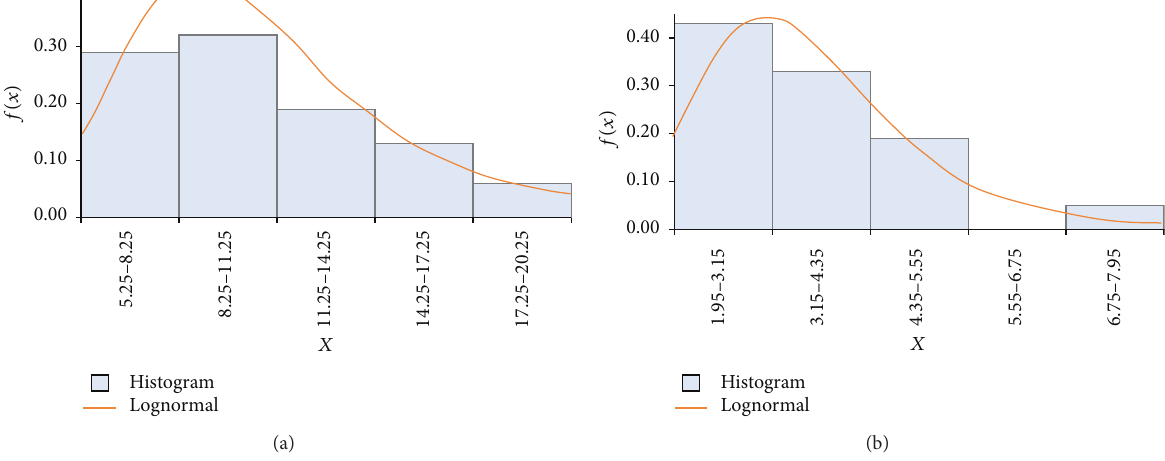
Figure 3: Probability density function at (a) Chamriz station in September and (b) Dehkadeh-Sefid station in September.